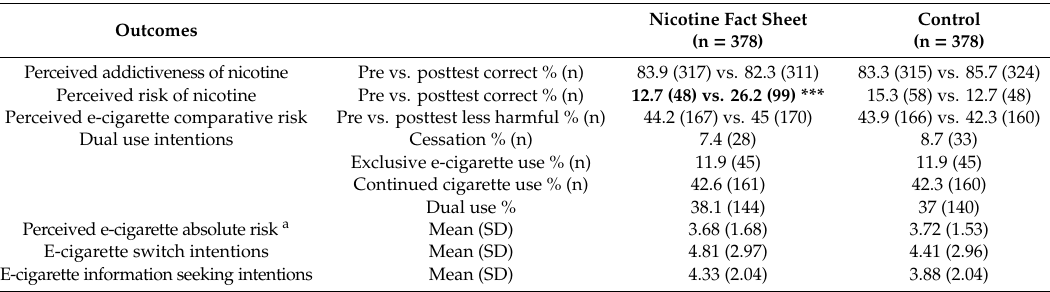
Table 3. Descriptive statistics of key outcomes.